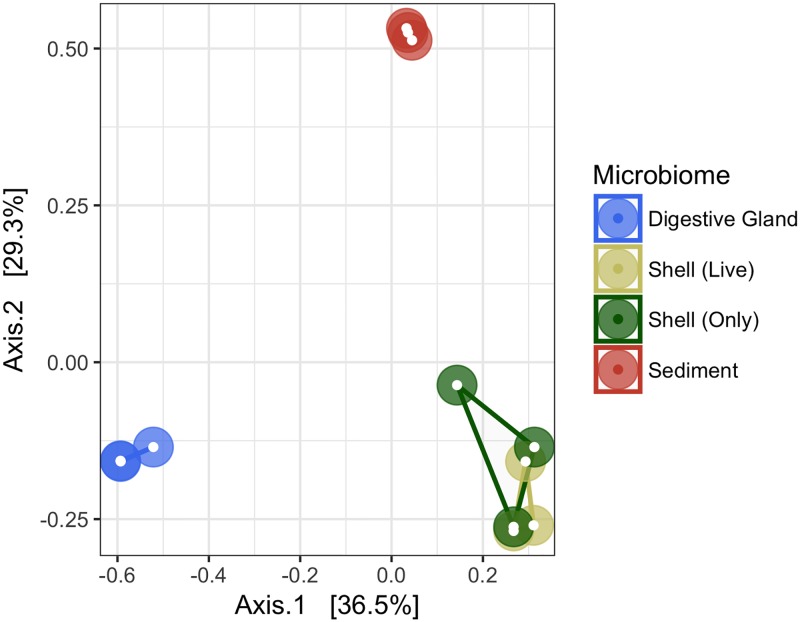
Principal coordinate analysis (PCoA) of oyster-related microbiomes.PCoA based on 16S rRNA gene sequences using Bray-Curtis similarity matrix.